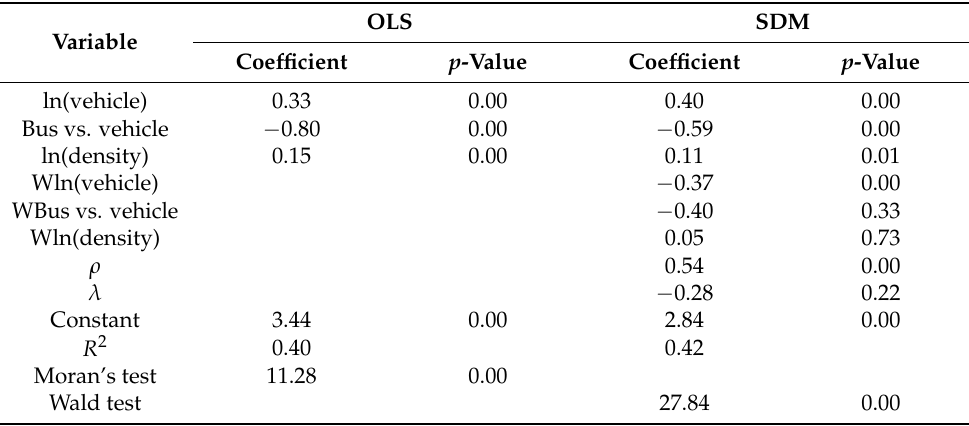
Table 7. Results of model with dependent variable ln ( NOx